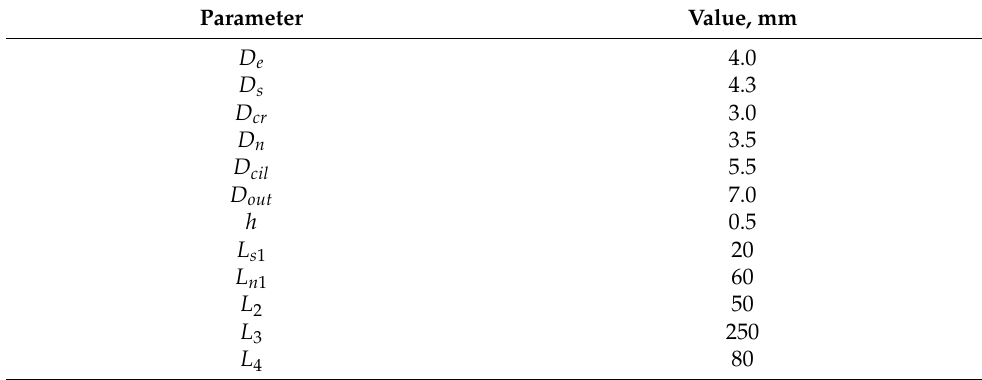
Table 3. The boundary conditions.